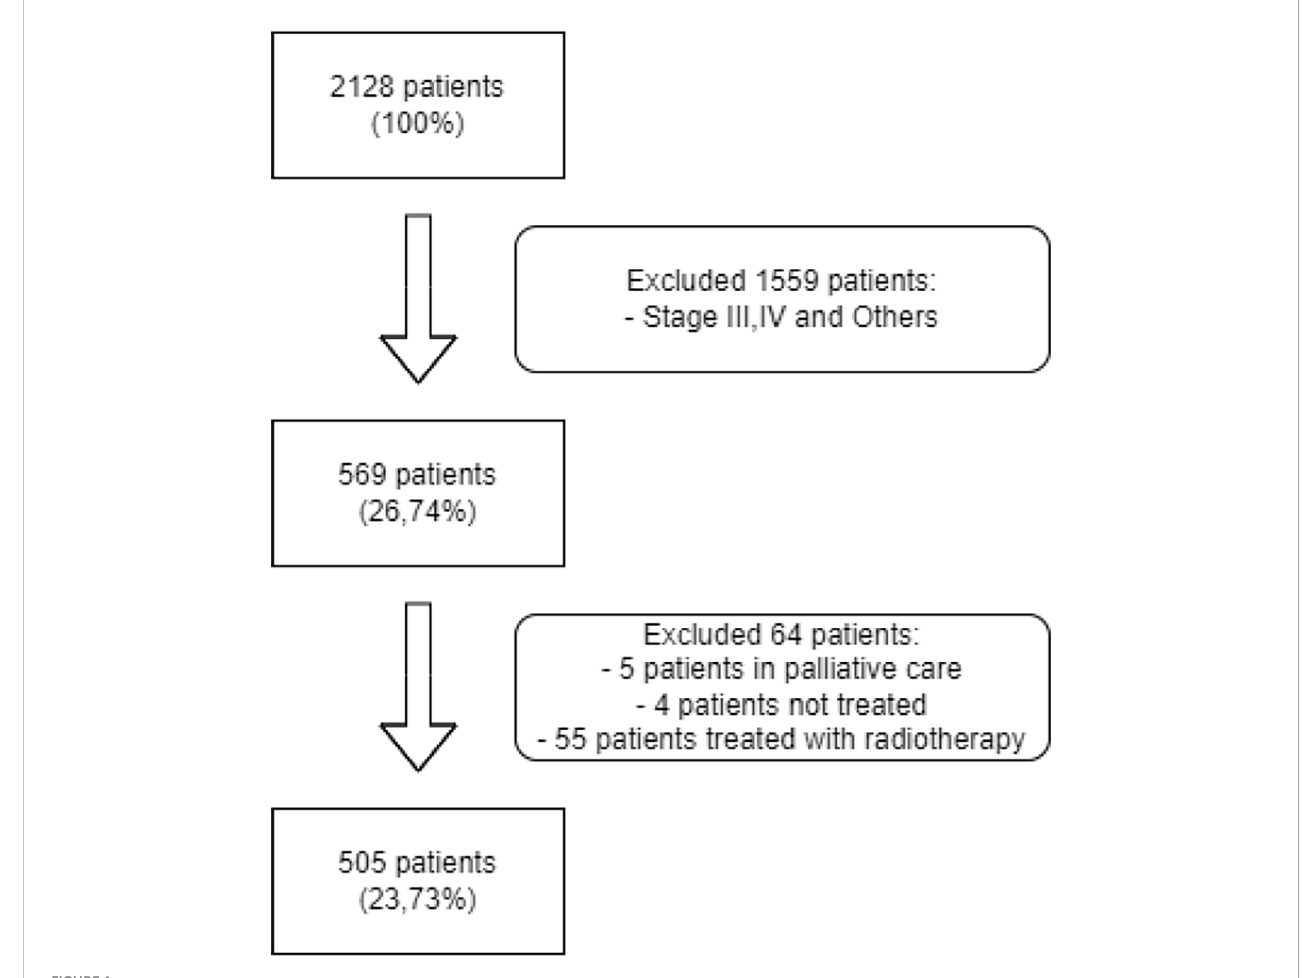
FIGURE 1 Flow Diagram for patient